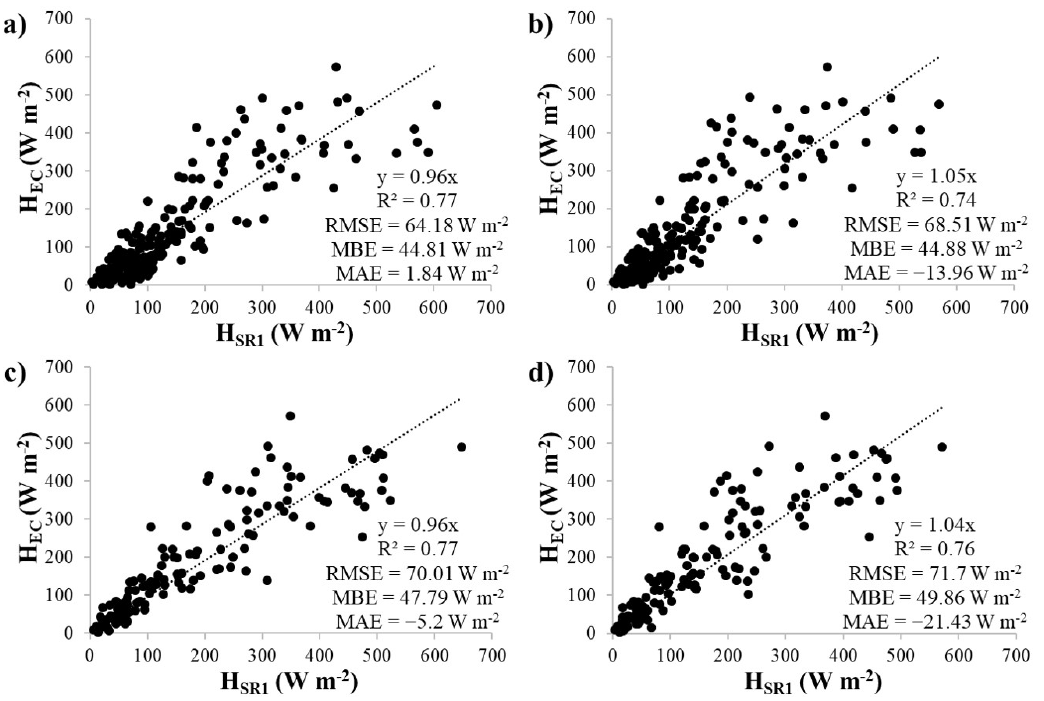
Figure 3. Linear regression analysis between H SR1 and H EC at the control plot for the upper thermo- couple using time lags of ( a ) 0.4 s and ( b ) 0.8 s and the lower thermocouple using time lags of ( c ) 0.4 s and ( d ) 0.8 s.